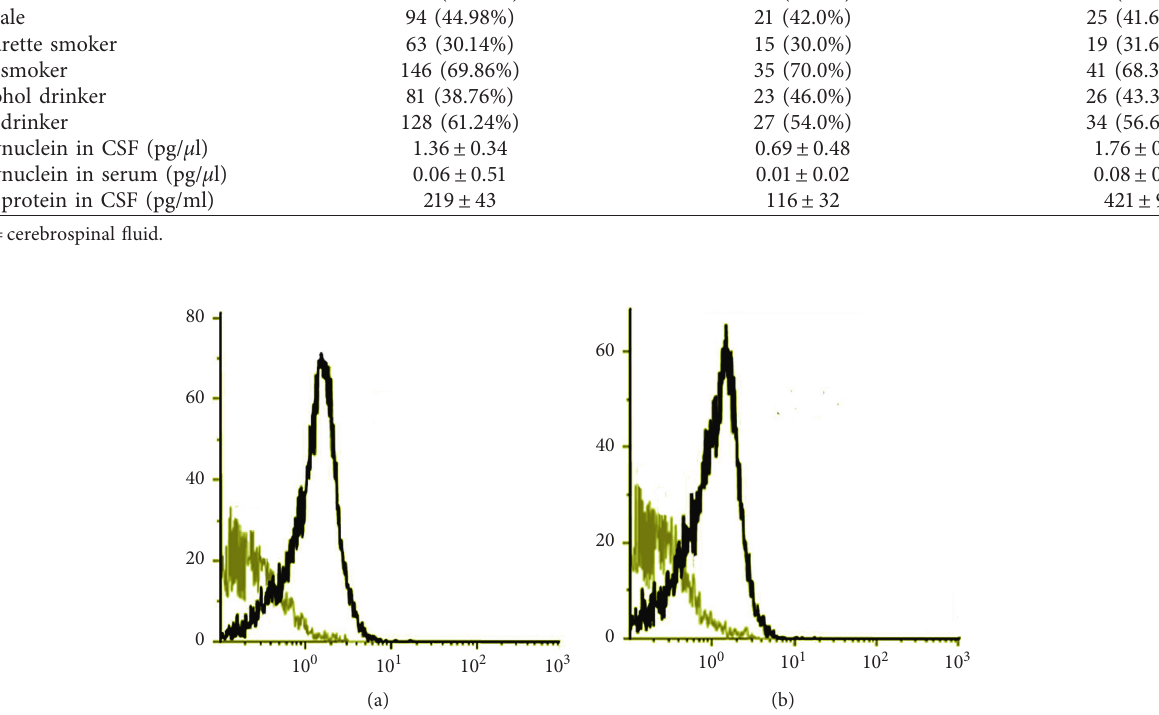
Figure 1: Flow cytometry analysis of (a) serum and (b) cerebrospinal fluid (CSF) exosomes displayed expression of CD63 surface